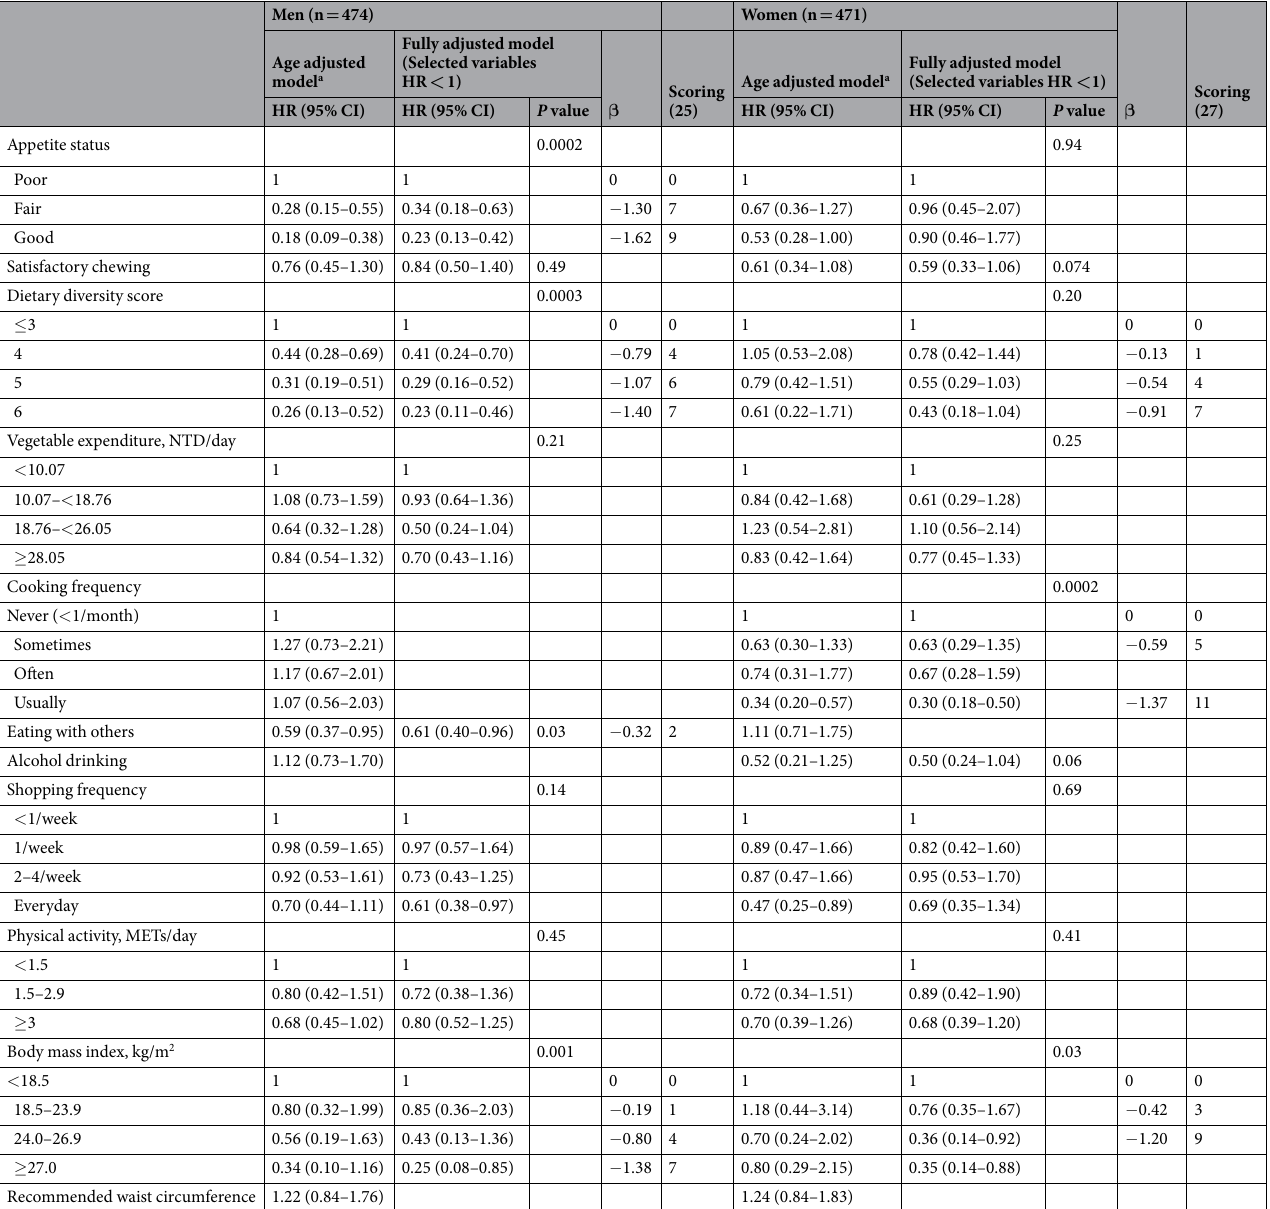
Table 2. Hazard ratios (95% confidence interval) of selected variables in the development set for HANI. Data were weighted for unequal probability of sampling design by SUDAAN and estimated Hazard ratio (95% confidence interval) by using the Cox proportional hazard model. a Adjusted for age for each variable. HANI: Healthy Ageing Nutrition Index; HR, hazard ratio; NTD, Taiwan New Dollar; METs, metabolic